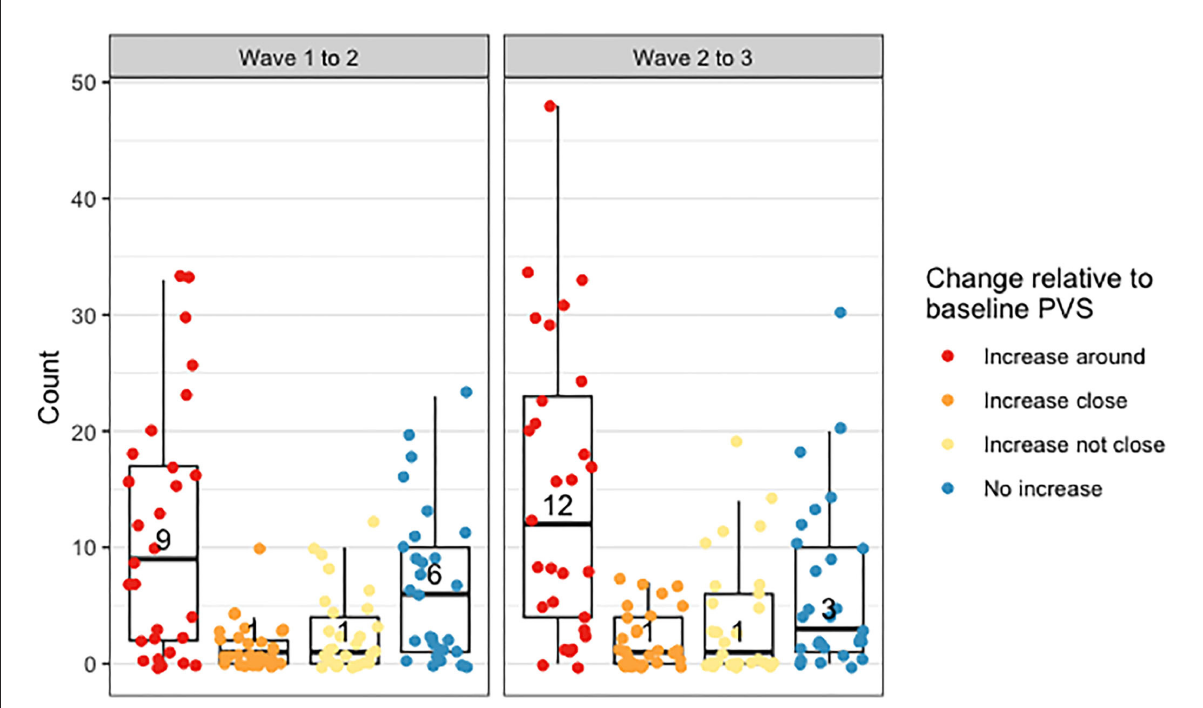
FIGURE8 Distribution of counts of deep WMH that increased around, close and not close to baseline PVS, and did not increase between waves 1 and 2 and waves 2 and 3. The points plotted on each boxplot represent a different participant in the sample, and the numbers represent the median